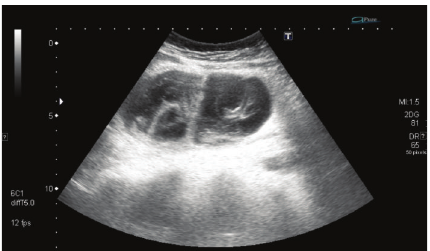
Figure 1: Ultrasound demonstrated a large abdominal, multilocular cystic mass. Notice the thick septations and echogenic content suspicious of a complicated